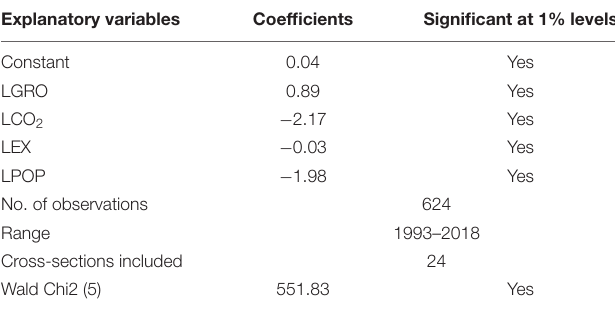
TABLE 7 | Estimation results for the high and upper-middle income